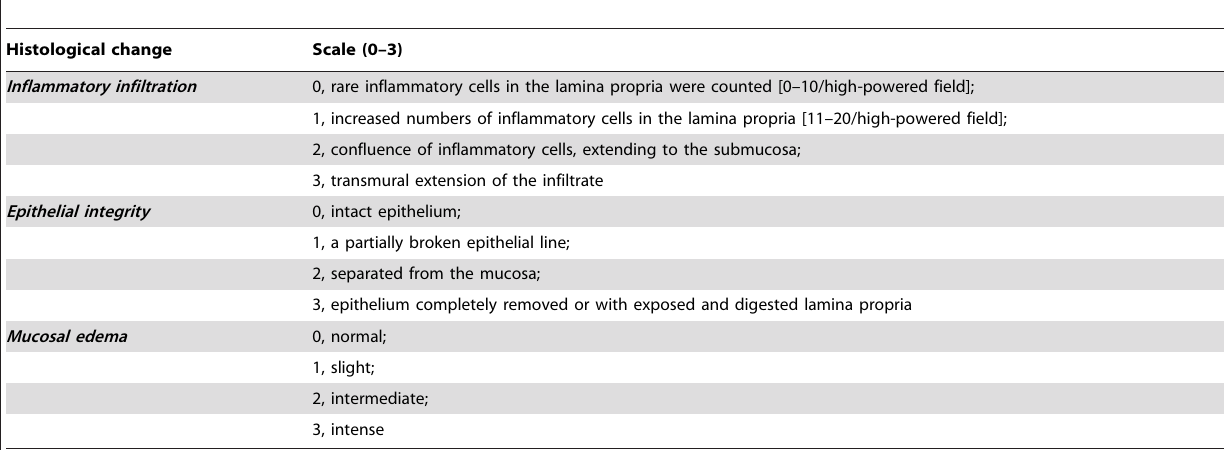
Table 1. Scoring criteria for histologic damage in colon